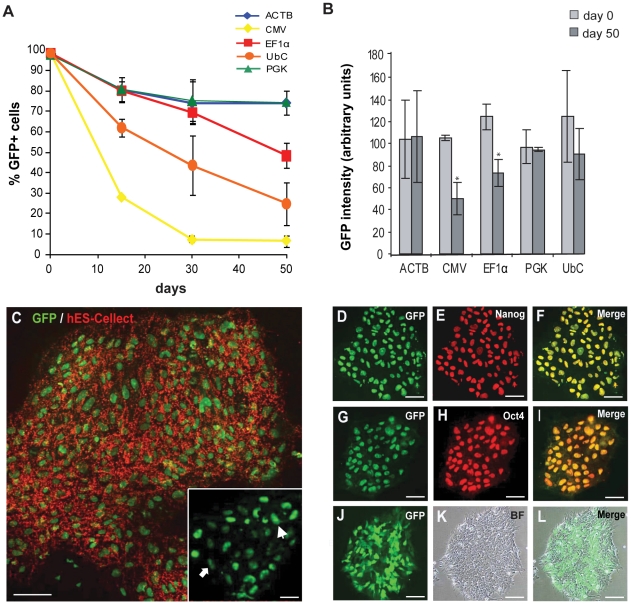
Constitutive promoter activity in long term culture of undifferentiated hESCs.The hESC line SA121 was transduced with lentiviral vectors containg the pTRIP-ACTB-, CMV-, EF1α-, PGK-or UbC-eGFP lentiviral vectors. 10 days after transduction, eGFP+ and eGFP− cells were separated by FACS sorting, referred to as day 0. Isolated eGFP+ cells were thereafter cultured for 50 days under self-renewing conditions and promoter activities were measured by FACS analysis at day 0, 15, 30, and 50. A. Promoter activities as percentage of eGFP+ cells at day 0, 15, 30 and 50. B. Intensity of fluorescent signal of eGFP expression from the same eGFP positive cells that were FACS analysed day 0 and 50. Intensity was measured by FACS analysis and EF1α promoter showed a significant decrease in intensity of eGFP expression from day 0 to day 50 (*p<0,014 students t'test). Decrease of ACTB-, CMV-, PGK- and UbC-eGFP intensity from day 0 to day 50 is not significant. A–C. Data are shown as mean of three independent experiments. Error bars represent standard deviation of the mean (± s.d.). C–L. Immunofluorescence stainings of ACTB-eGFP+ cells 30 days after FACS sorting. eGFP expressing cells show uniform expression of pluripotency markers; hES-Cellect (C), inset in C shows low and high intensity eGFP expressing cells, Nanog (D–F) and Oct3/4 (G–I). L. Merged image of colony morphology of human ES cells cultured on Matrigel (K) and eGFP expression within the colony (J). Scale bar in C represent 100 µM, inset and D–L 200 µM. Cells representative of high eGFP expressing is indicated by arrowhead and low eGFP expression by arrow.